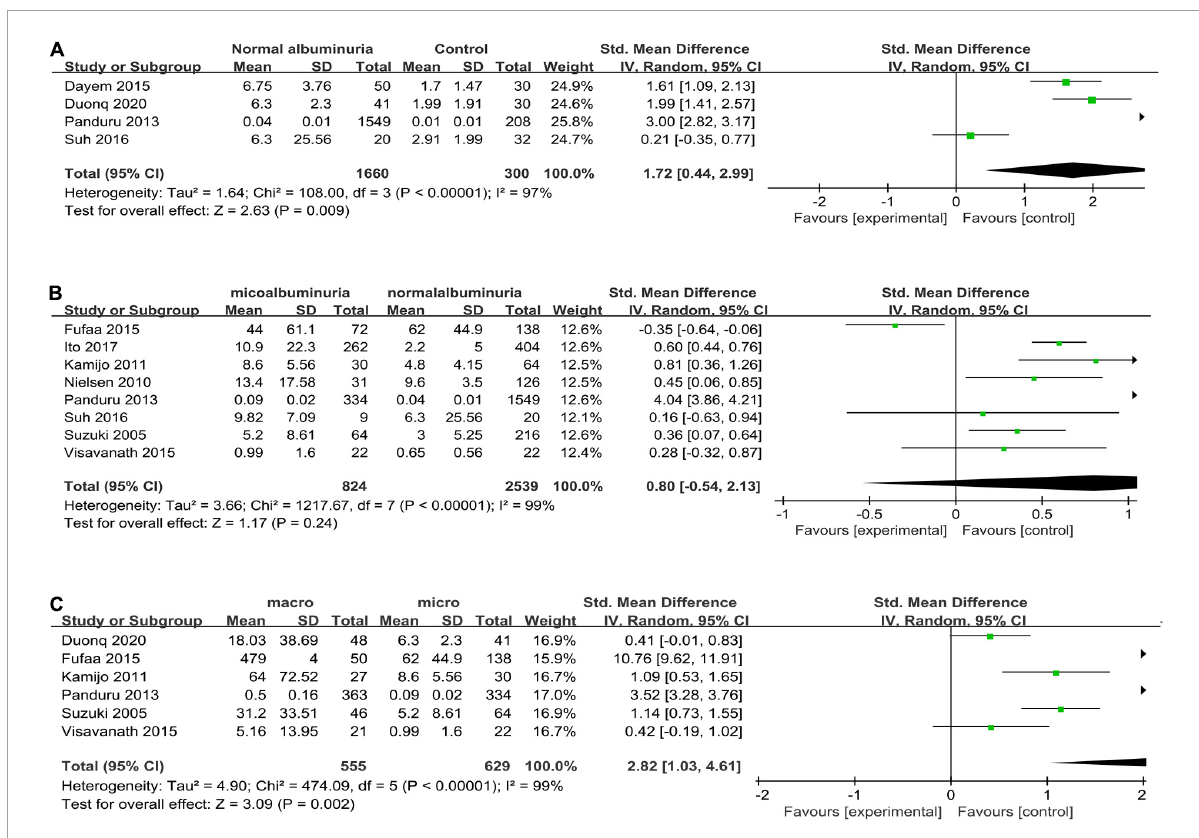
FIGURE2 (A) Forest plot of u-LFABP level comparison in normal control group and diabetic patients with normal albuminuria group; (B) Forest plot of u-LFABP level comparison in diabetic patients with micro albuminuria group and normal albuminuria group; (C) Forest plot of u-LFABP level comparison in diabetic patients with macro albuminuria group and micro albuminuria